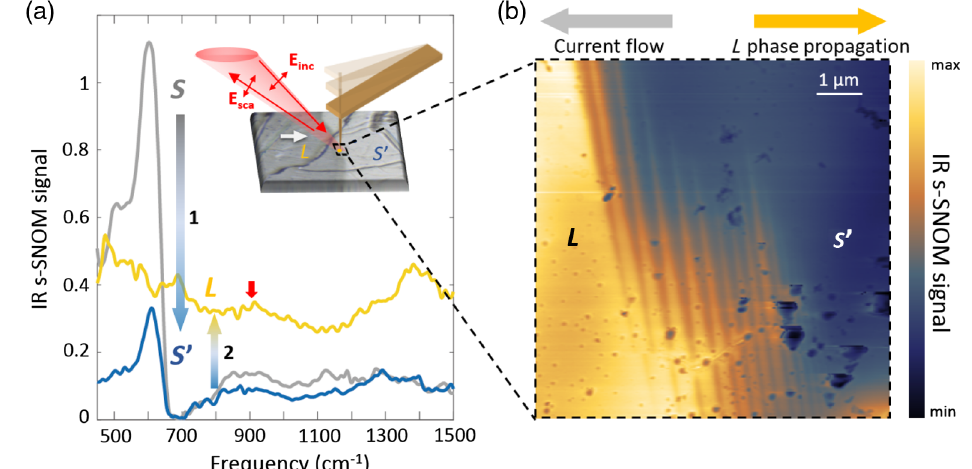
current.FIG. 2. (a) IR nano spectra of S , S 0 , and L states. The spectrum of S (gray) is taken without a current, while the spectra of S 0 (blue) and